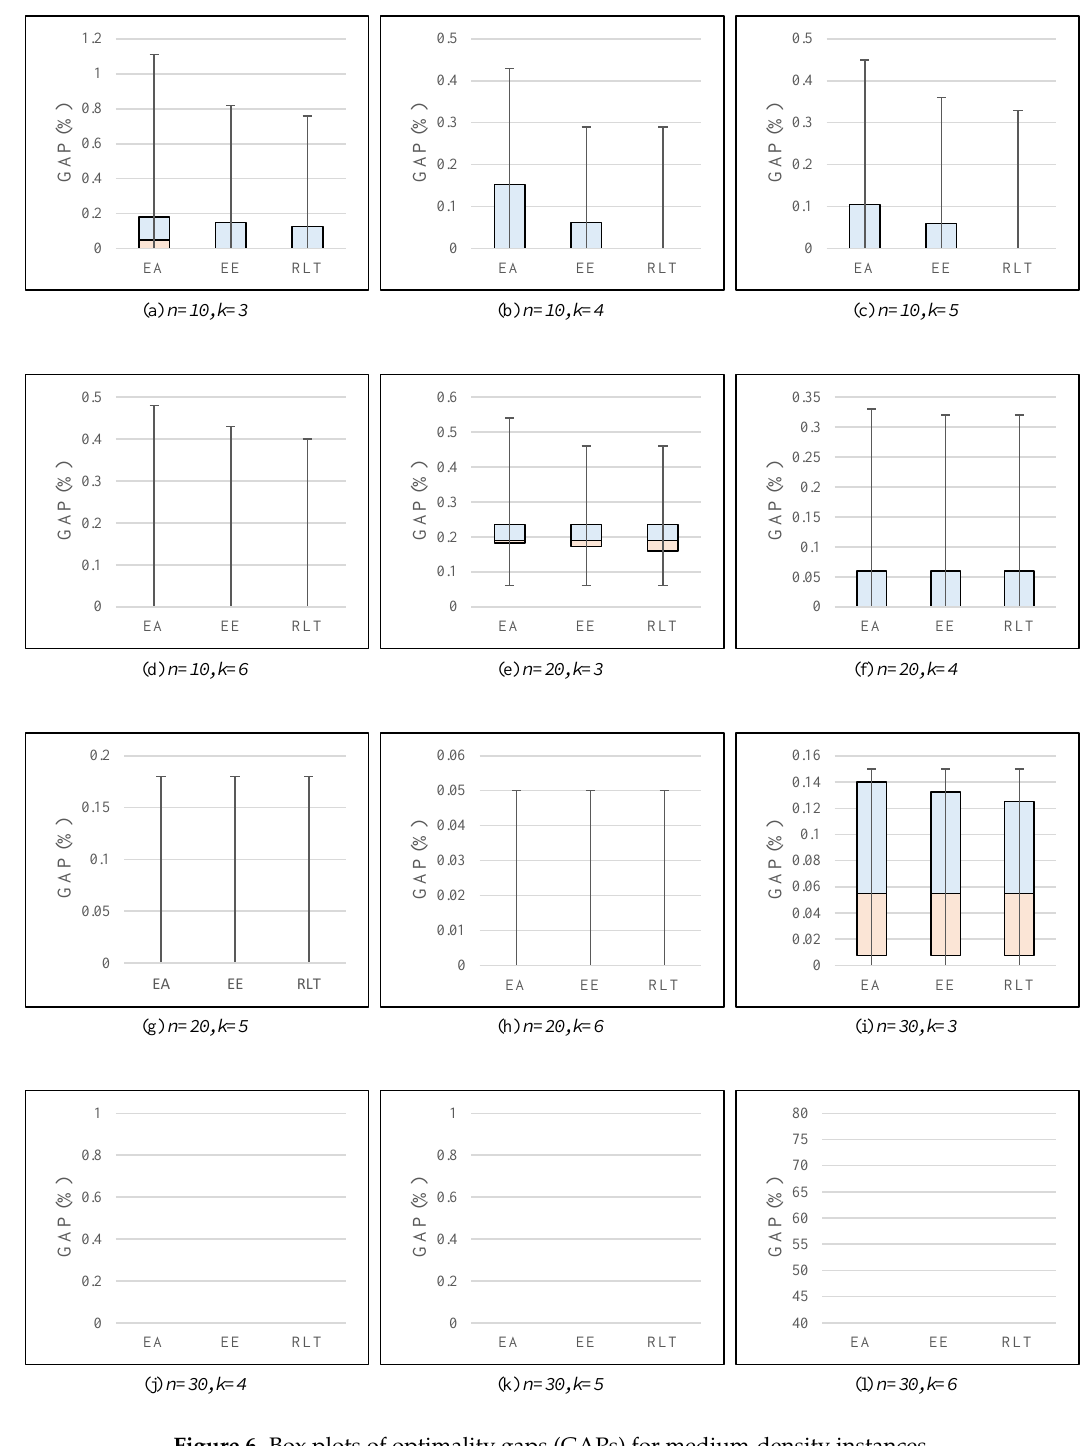
Figure 6. Box plots of optimality gaps (GAPs) for medium-density